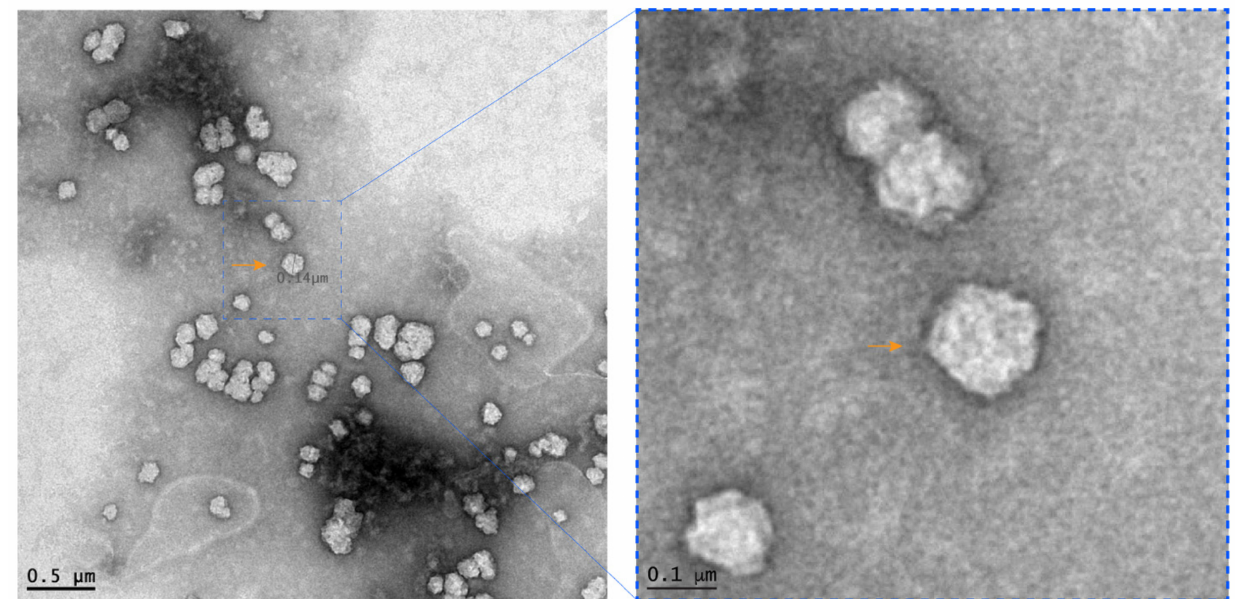
Figure 1. Transmission electron microscopy analysis of rotavirus particles in the feces of a diarrheic foal. Negative stain (the left image) shows single and clusters of round non-enveloped electron-lucent particles with electron-dense “surface holes” characteristic of rotavirus particles (Bar = 500 nm). Note that the right panel is the scaled-up image of the indicated field in the original TEM image (Bar = 100